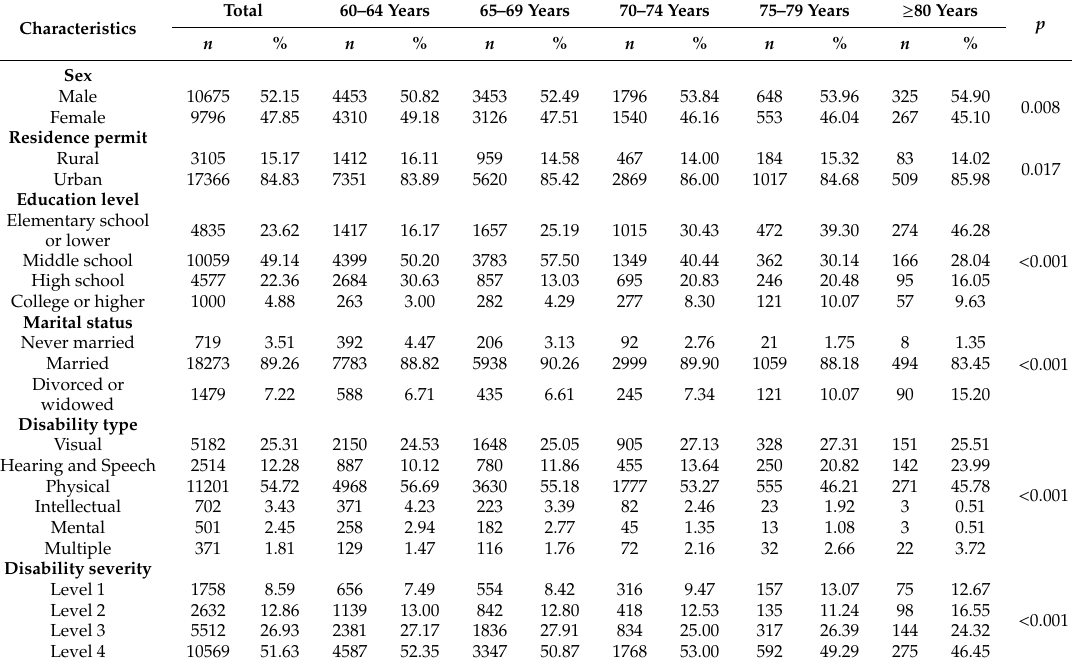
Table 1. Sociodemographic and disability characteristics of the sample stratified by age